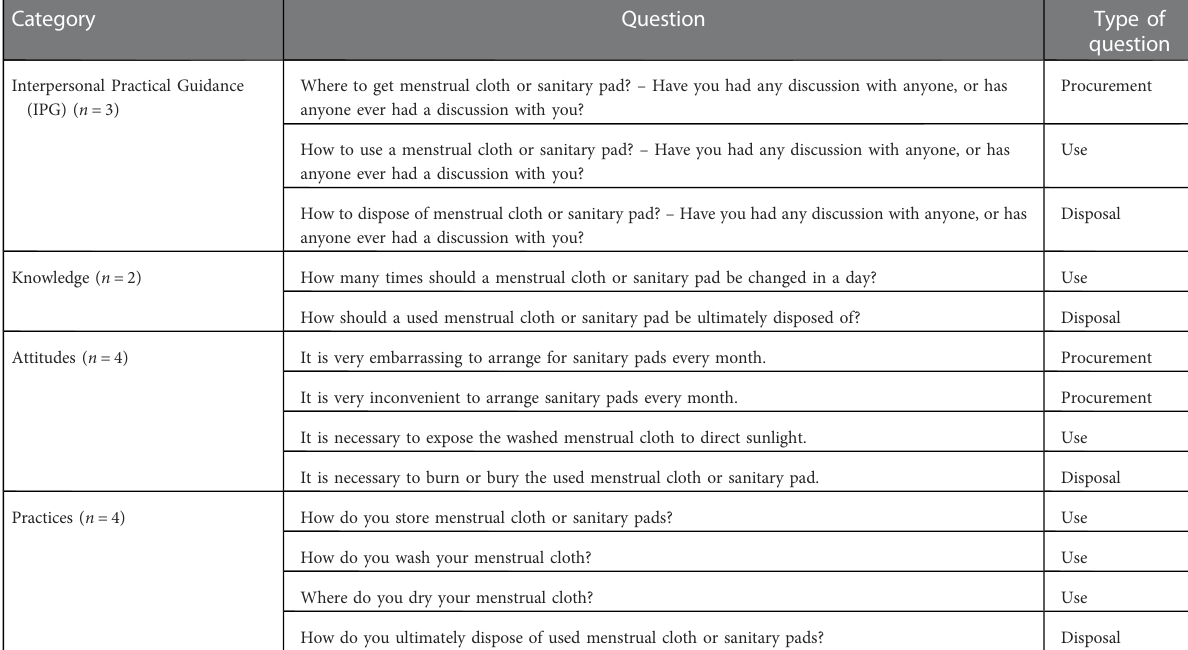
TABLE 1 Selected questions from the original SBCC intervention questionnaire ( n =13).